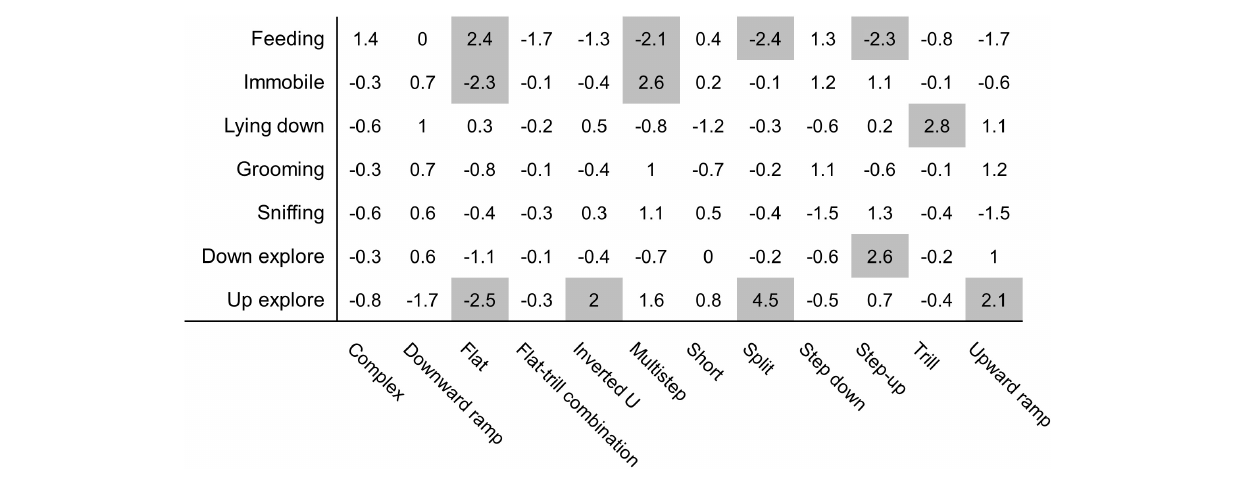
FIGURE5 Monte Carlo shuffling analysis reveals association between USVs produced and specific behaviours. Each USV produced during the feeding phase, and the behaviour performed upon vocalising, was analysed using Monte Carlo shuffling simulations. Those analyses resulted in z -values representing a probability of association. A z -value above 2 and below − 2 (highlighted in grey) represent, respectively, a statistically significant association or lack of association between behaviour and USV ( p = 0.0455 or below) N = 16